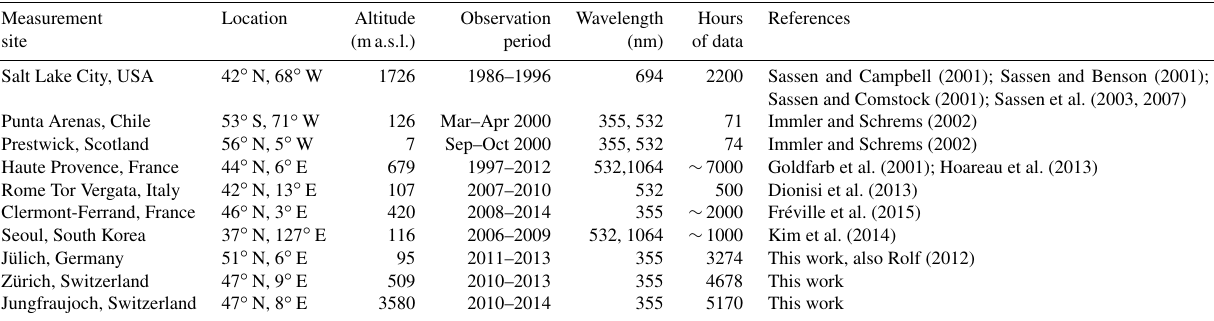
Table 1. Lidar stations that have been used for systematic climatological studies of cirrus clouds in the midlatitudes. Measurement Location Altitude Observation Wavelength Hours References site (ma.s.l.) period (nm) of data Salt Lake City, USA 42 ◦ N, 68 ◦ W